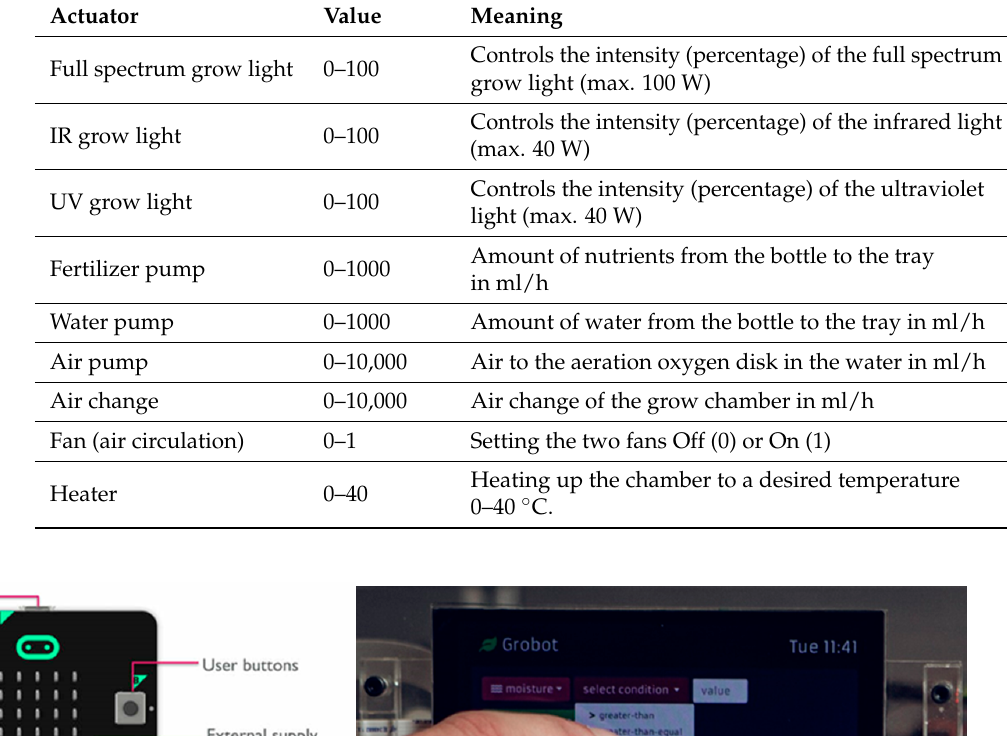
Table 3. GrowBot actuators.